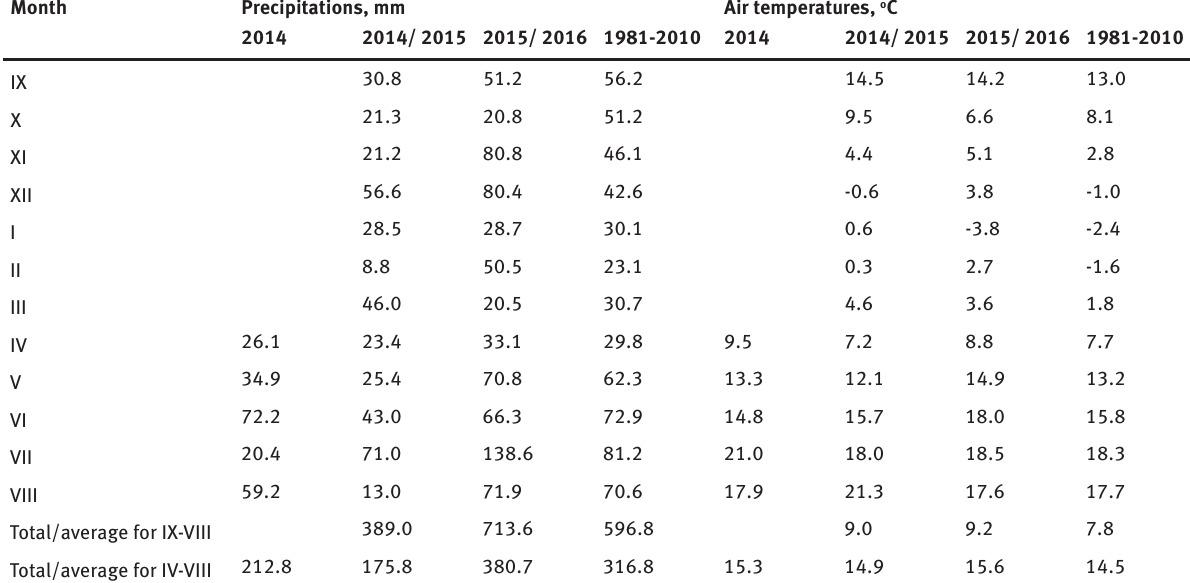
Table 6: Precipitations and air temperatures during the period of study according to the Meteorological Station in Bałcyny.